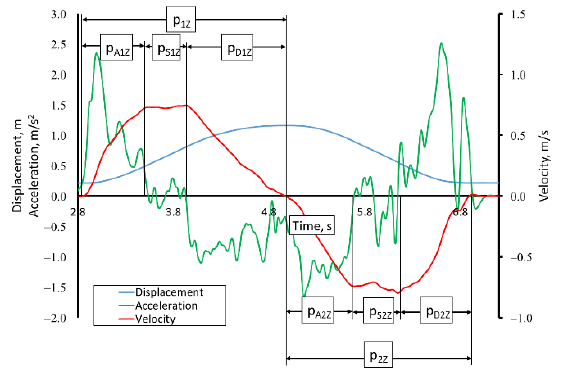
Figure 5. An example course of changes in displacement, velocity, and acceleration for the vertical hand movement (displacement: 930 mm), where p is the phase of the movement.